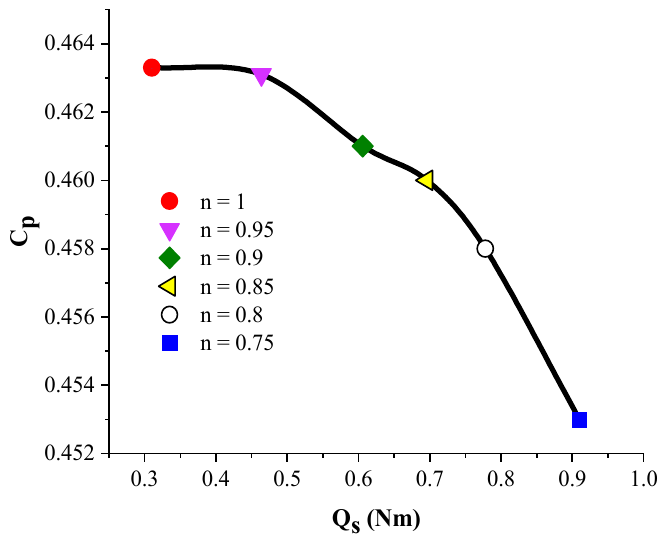
Figure 8. The Pareto front for the optimized blades.